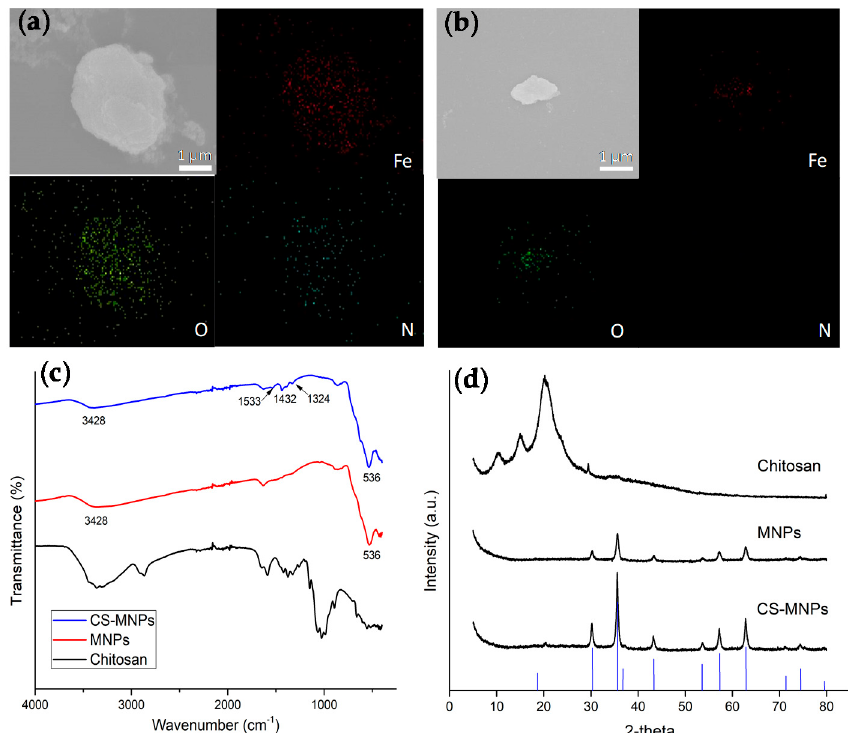
Figure 2. SEM images of ( a ) CS-MNPs and ( b ) MNPs with their corresponding EDS maps of Fe, O, and N. ( c ) FT-IR spectra and ( d ) XRD spectra for CS-MNPs, MNPs, and chitosan.